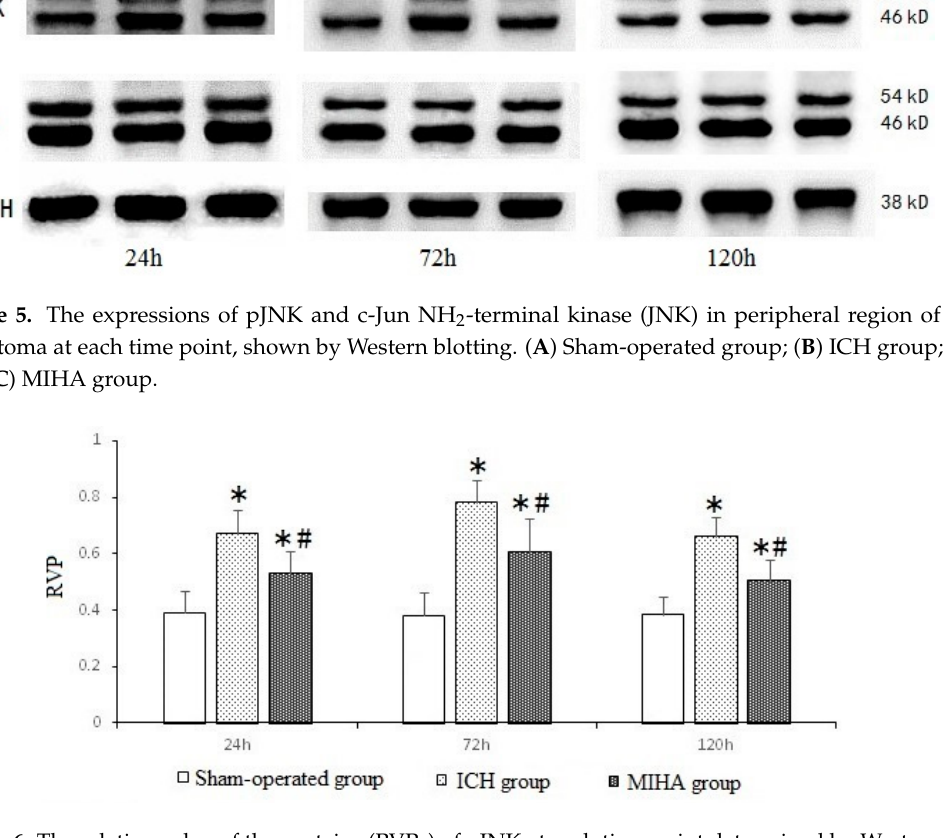
Figure 6. The relative value of the proteins (RVPs) of pJNK at each time point determined by Western blotting. * p < 0.05 vs. the sham-operated group, # p < 0.05 vs. the ICH group.